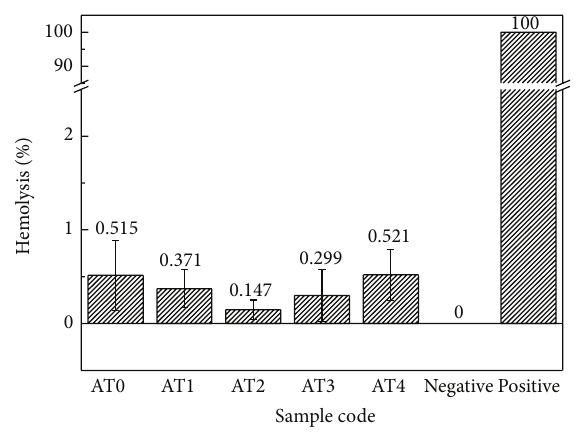
Figure 8: Hemolysis percentage of various heat treated Mg-35Zn- 3Ca